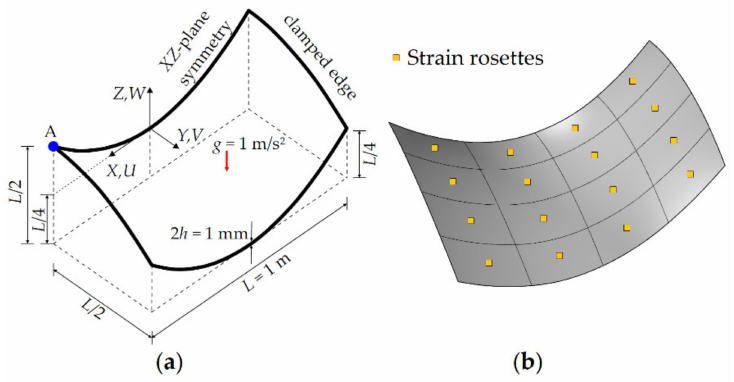
Figure 13. ( a ) Hyperbolic paraboloid with symmetric boundary conditions; ( b ) its discretization (n e = 4) using iKLS elements with top- and bottom-surface strain rosettes per each